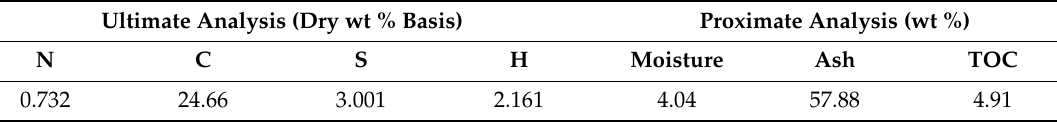
Table 1. Compositional analysis of the shale sample.